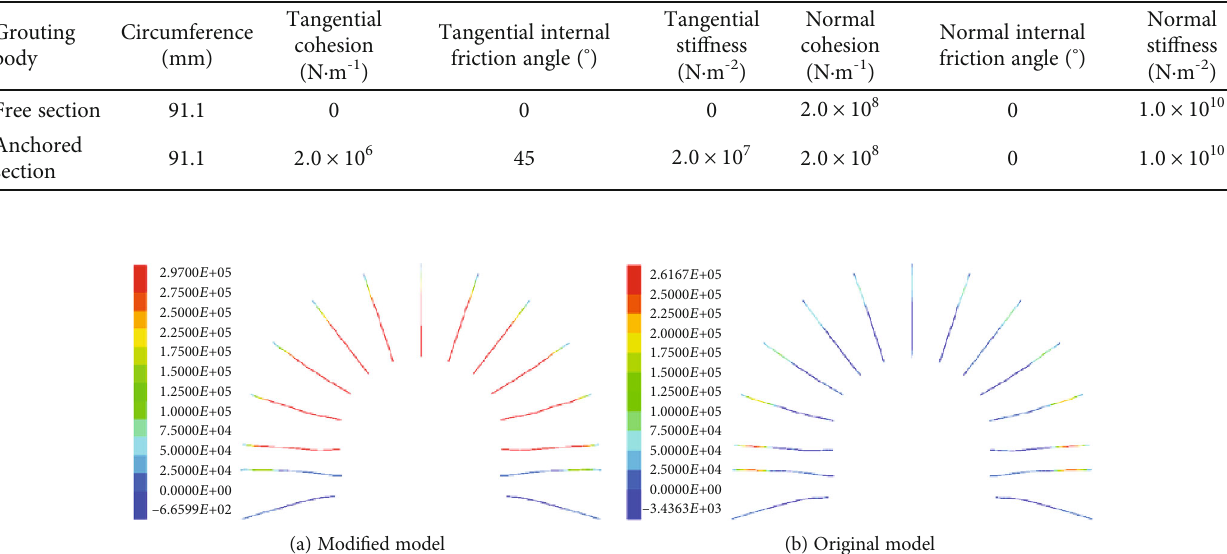
Figure 12: The rock bolt axial load distribution state when the modi fi ed model and the original model arrive at the calculation balance.